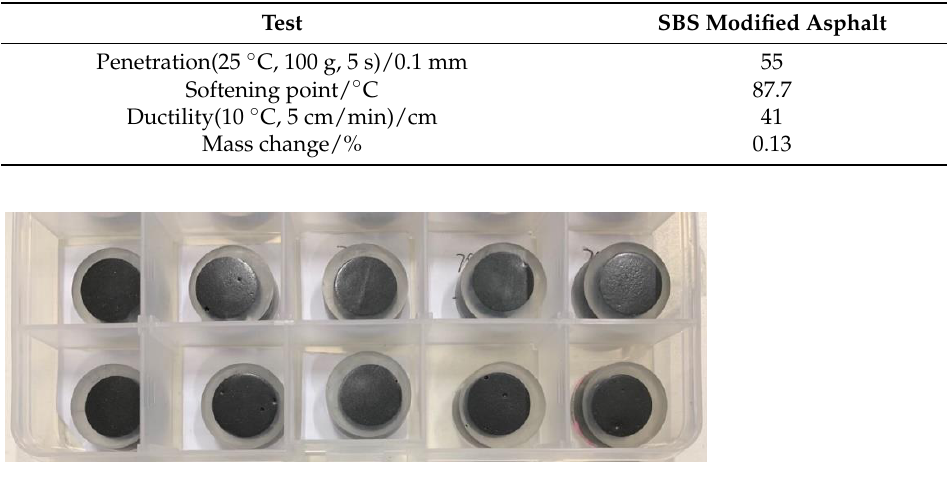
Figure 3. Nanoindentation asphalt mastic specimens.